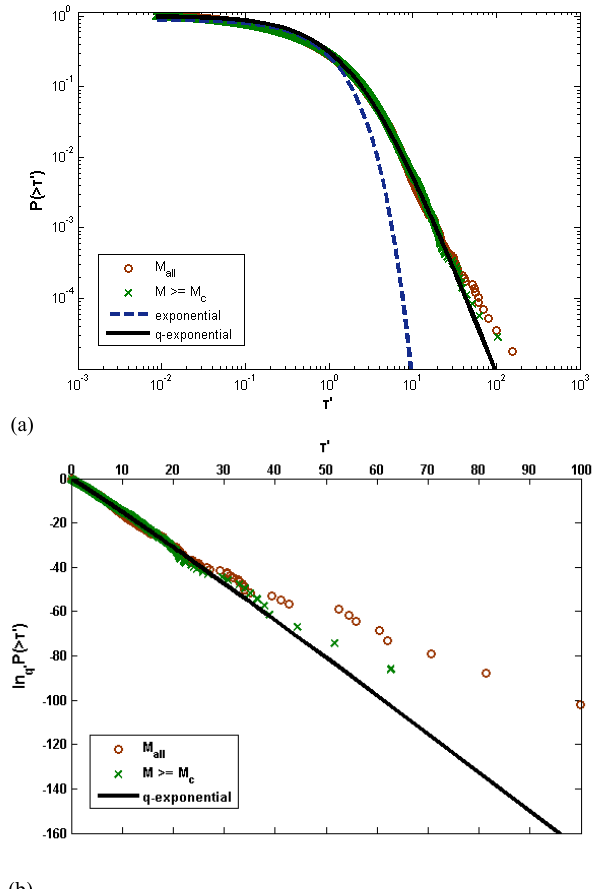
Fig. 6. (a) Log-log plot of P(> τ 0 ) for the entire dataset (circles) and for M ≥ M c (crosses). The solid line represents the q -exponential distribution of Eq. (30) for the values of q = 1 . 25 ± 0 . 02 and B q = 1 . 9 ± 0 . 3. An exponential distribution (dashed line) is also plotted for comparison. (b) The corresponding q -logarithmic distributions ln q 0 (P(> τ 0 )) for the entire dataset (circles) and for M ≥ M c (crosses), exhibiting correlation coefficients ρ = − 0 . 9842 and ρ = − 0 . 9952, respectively. The straight line is the q -exponential distribution.